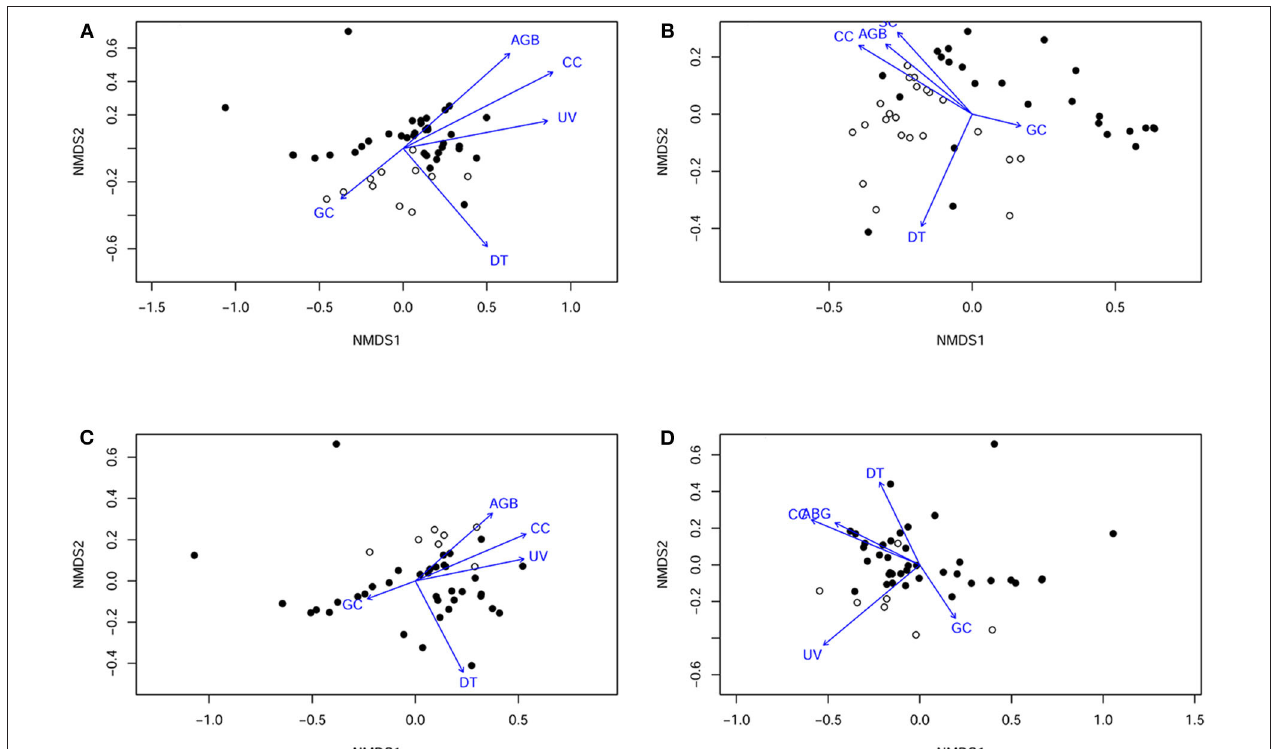
FIGURE 3 | Non-metric multidimensional scaling plots showing predation across of different prey items– (A) artificial nests; (B) artificial seeds (C) caterpillar models; and (D) frog models—across all sites, with sites where predation occurred and did not occur indicated, and each variable included in the analysis plotted accordingly. AGB, aboveground biomass; CC, canopy cover; DT, dead trees; GC, ground cover; SC, shrub cover; and UV, understorey volume. Open circles are sites where predation occurred, and black circles where artificial prey models were left untouched.